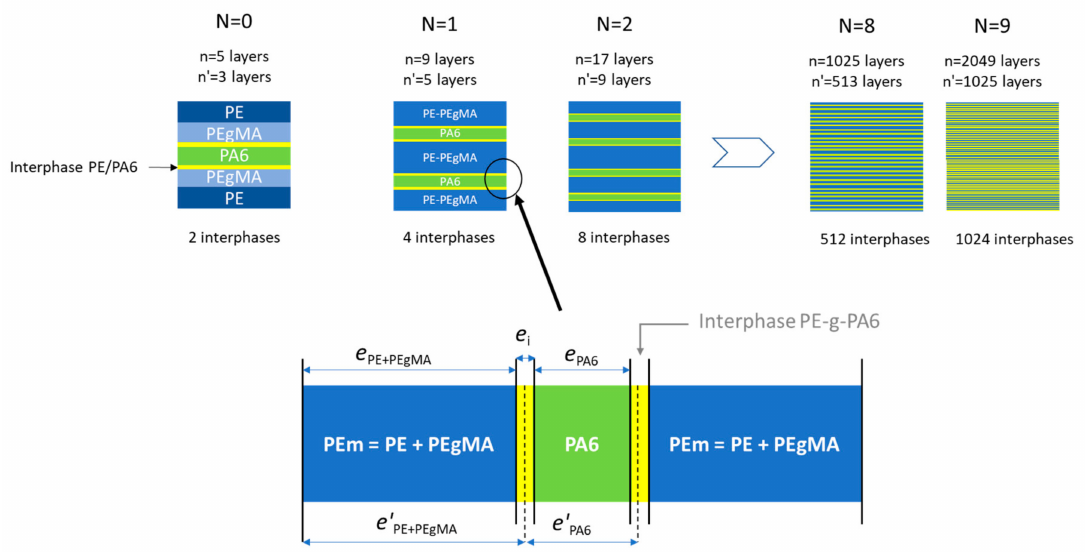
Figure 7. Schematic representation of the three phases (PE/interphase/PA6) model for permeation. (N = number of LME, n = the theoretical number of layers, n (cid:48) = the number of layers assuming PE and PEgMA as one phase that is